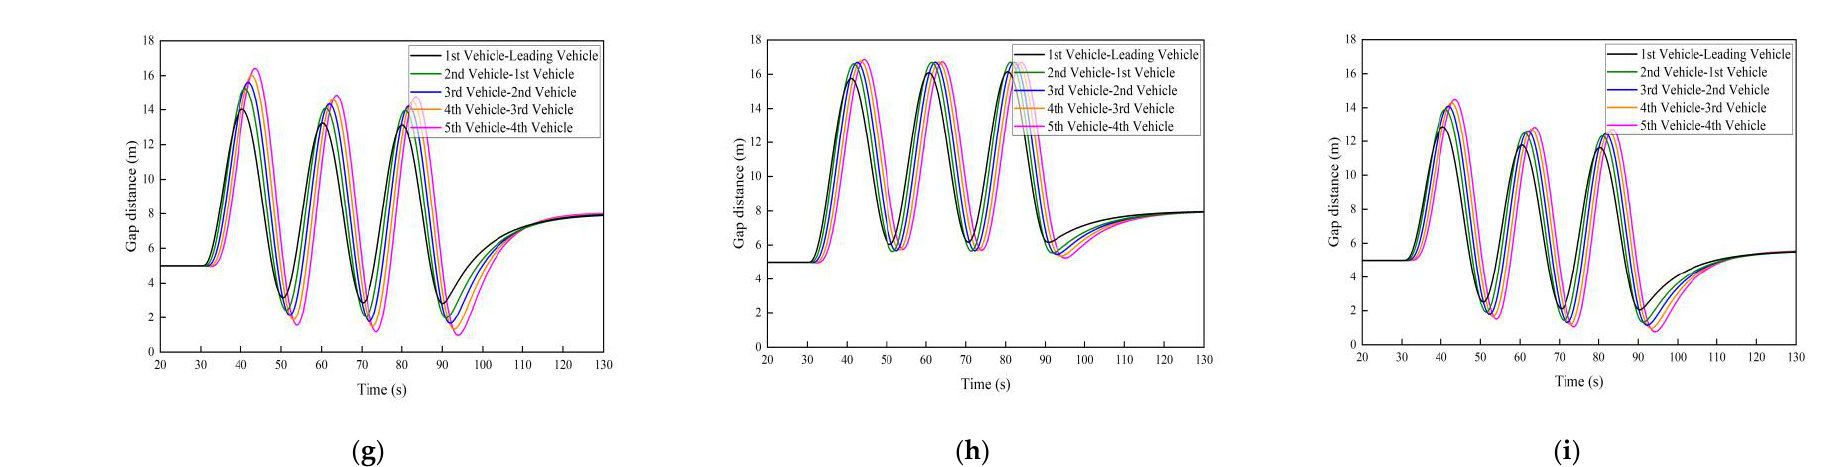
Figure 11. Comparison results under three different control strategies. ( a ) Velocity changes in the constant spacing strategy; ( b ) Velocity changes in the constant time headway strategy; ( c ) Velocity changes in in the potential field-based strategy; ( d ) Acceleration changes in the constant spacing strategy; ( e ) Acceleration changes in the constant time headway strategy; ( f ) Acceleration in the potential field-based strategy; ( g ) Gap distance changes in the constant spacing strategy; ( h ) Gap distance changes in the constant time headway strategy; ( i ) Gap distance changes in the potential field-based strategy.